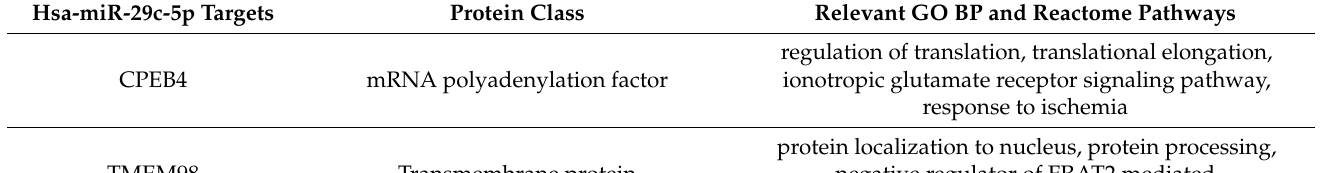
Table 2. Relevant targets of breast density associated hsa-miR-29c-5p. Targets are confirmed by strong (luciferase reporter assays, Western blot, or qPCR) or weaker experimental evidence (next generation sequencing, microarray, or others, annotated with *). Protein class, Gene Ontology (GO) biological process (BP) and Reactome pathways were explored via PANTHER 16.0 pathway analysis (http://www.pantherdb.org/ (accessed on 23 February 2022)) and